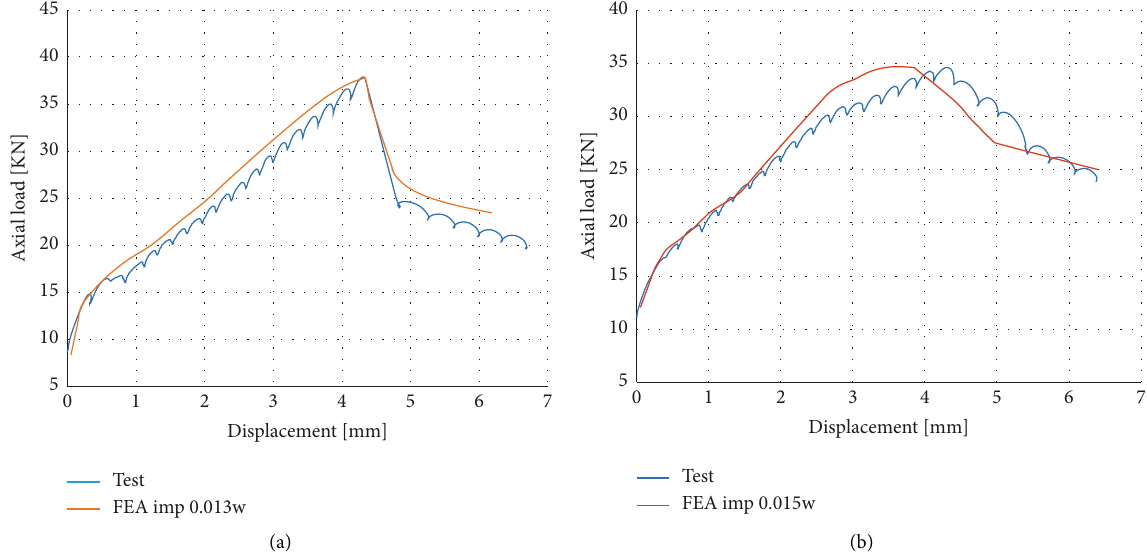
Figure 24: Experimental and numerical axial load-displacement curves of the 600mm (a) and 2,000 mm (b) braced